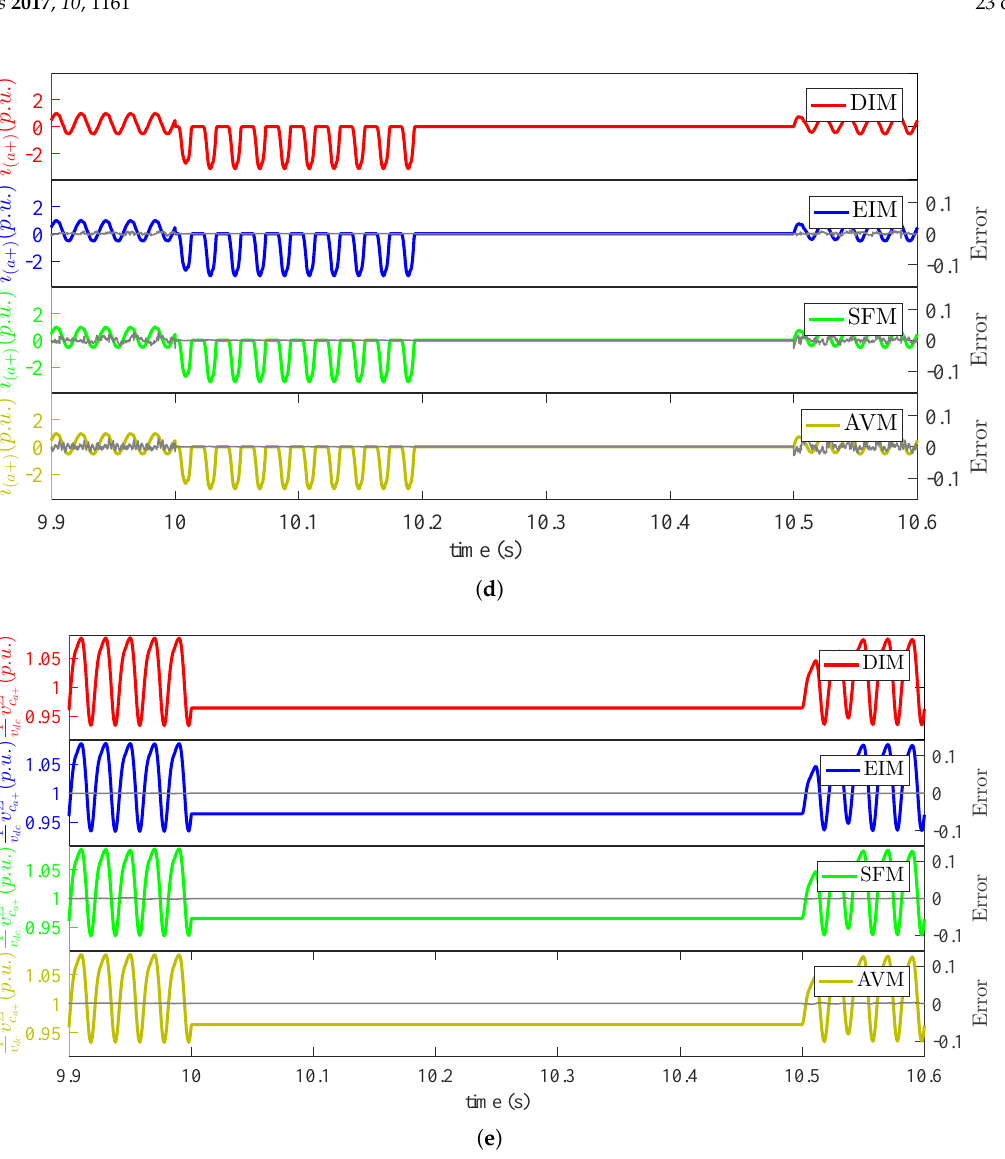
and the modelerror; ( b ) AC current i ac a ∑ and the model C ( a +)